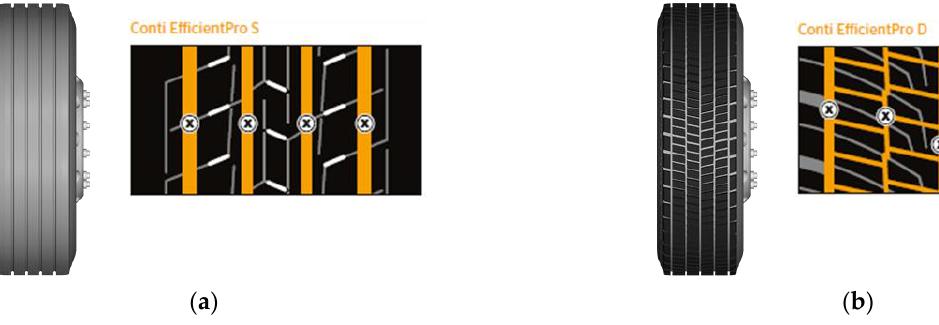
Figure 3. Investigated tread topologies: ( a ) Front wheel with longitudinal grooves; ( b ) Front wheel with treaded pattern.